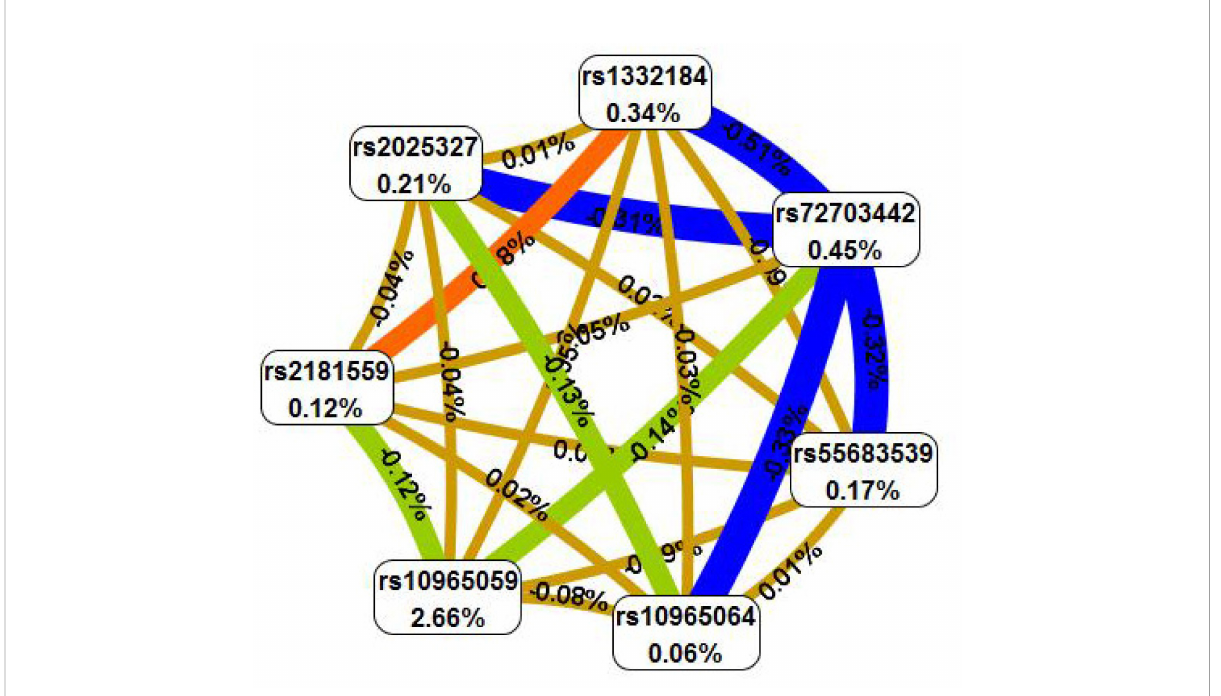
FIGURE 2 The Fruchterman-Reingold of SNP-SNP interactions. Each SNP is reported in per cent the value of Information Gain (IG), while numbers in the connections indicate the entropy-based IG for the SNP pairs. Orange bar indicate the high-level synergies on the phenotype, while the brown indicate a medium-level interaction, green and blue connections with negative IG values indicate redundancy or lack of synergistic interactions between the